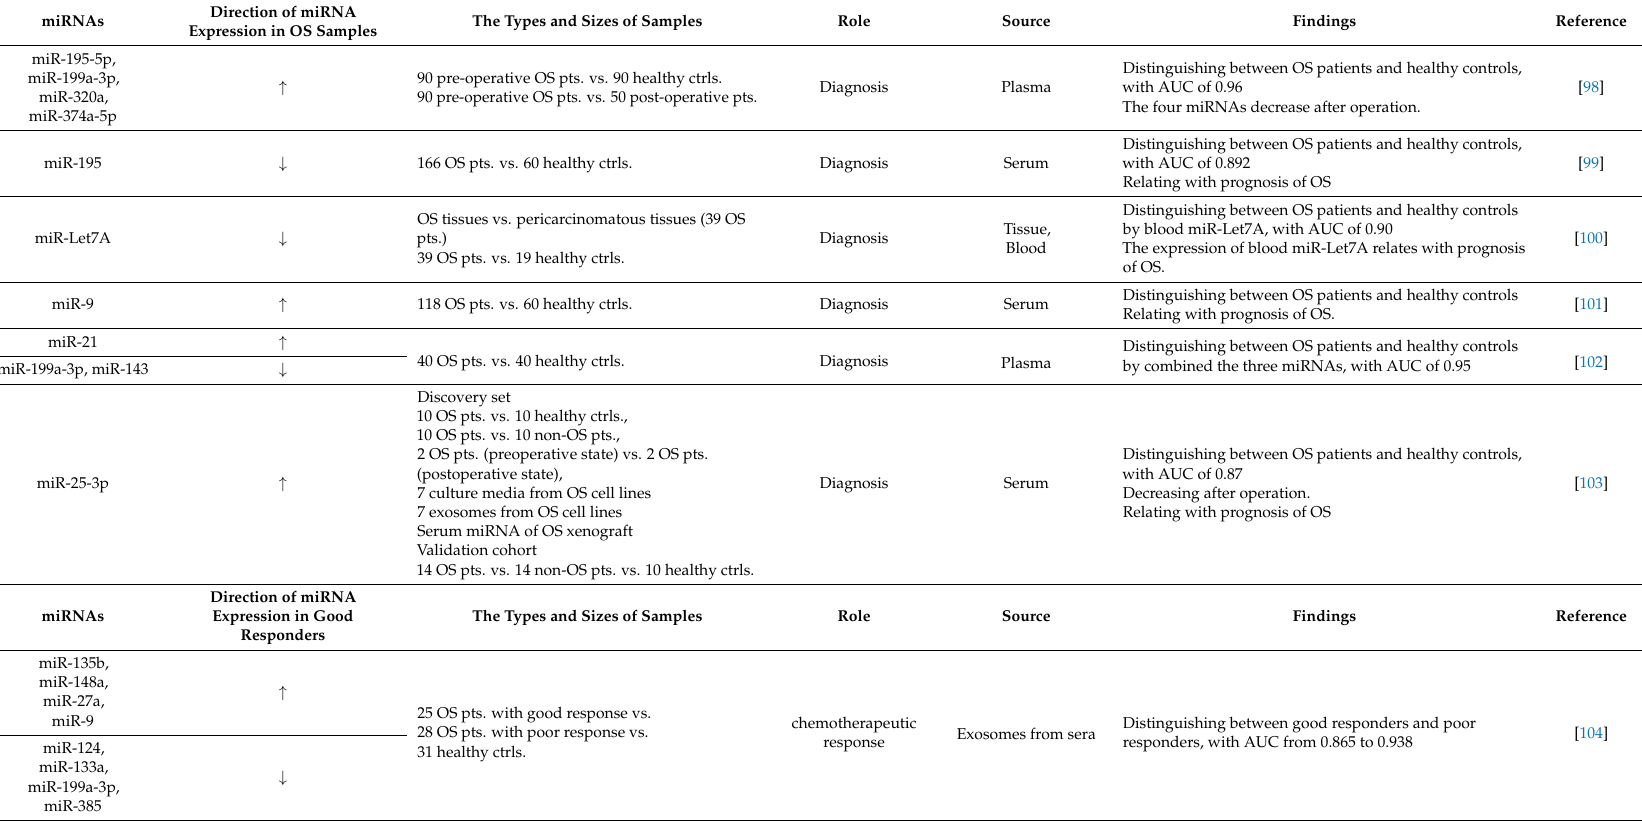
Table 2. The promising miRNAs as biomarkers of Osteosarcoma (OS).